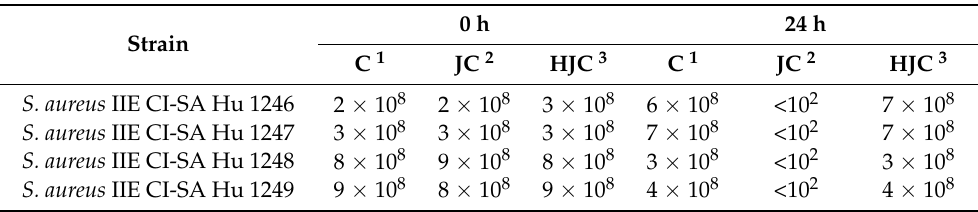
Table 2. Antagonistic activity of LF3872 against S. aureus clinical isolates from the milk of women with mastitis.